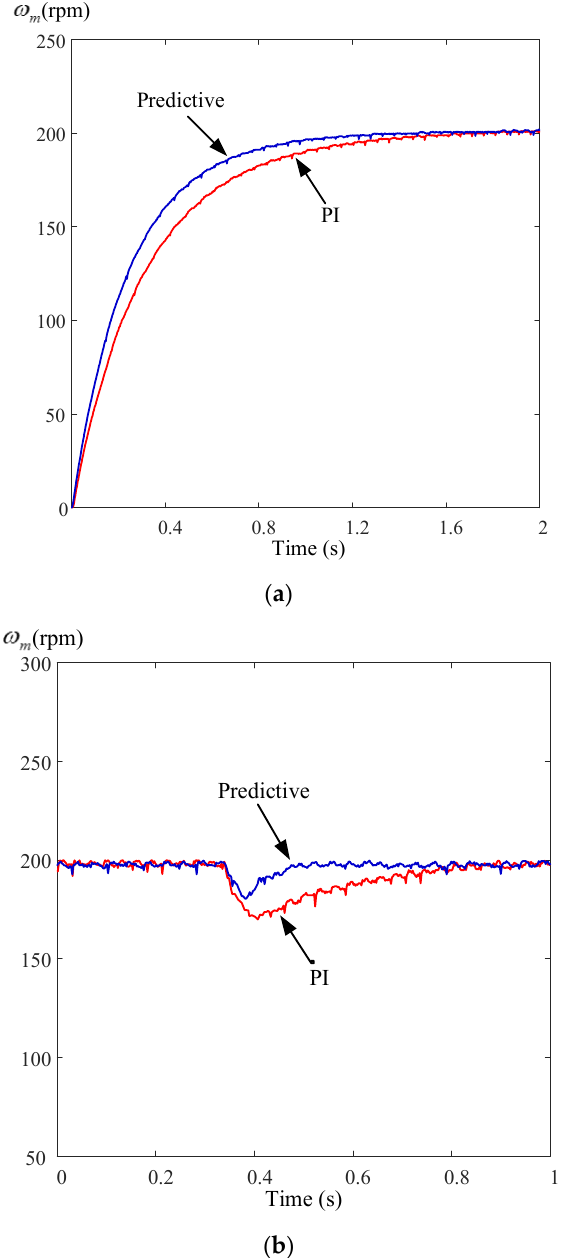
Figure 11. Measured responses using di ff erent controllers. ( a ) transient, ( b ) load disturbance.